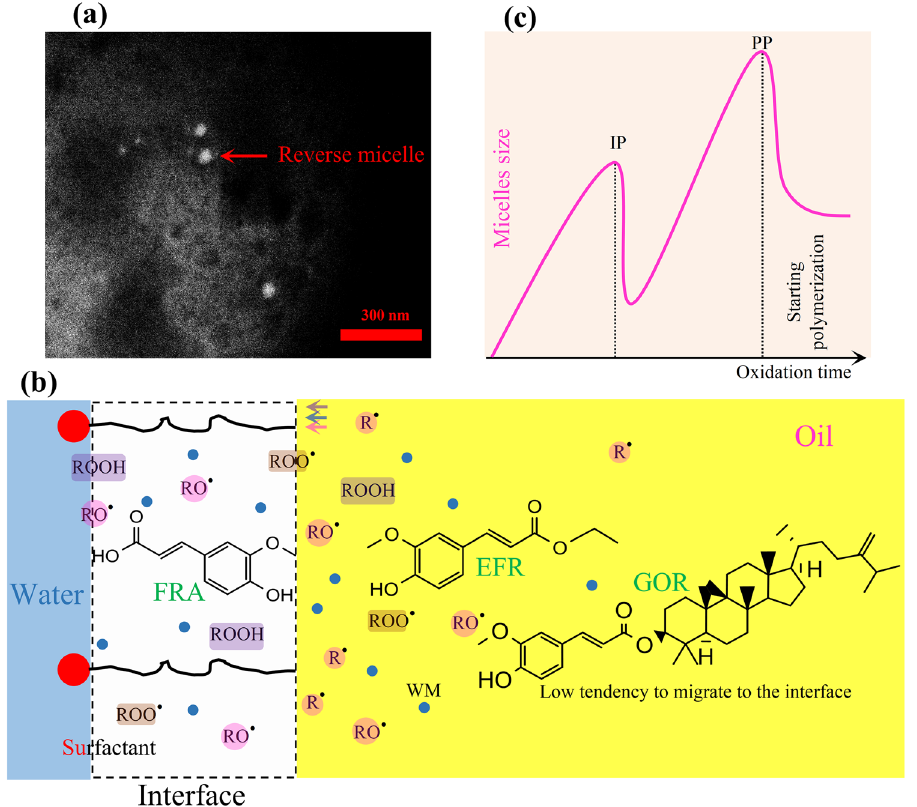
Figure 3. ( a ) TEM image of reverse micelles structures in the presence of γ-oryzanol during the induction period, ( b ) schematic figure of the cross-section of a reverse micelle produced during the oxidation process and a display of the dynamics of oxidation products as well as partitioning of the antioxidants under study in this structure ( EFR ethyl ferulate, FRA ferulic acid, GOR γ-oryzanol, R • alkyl radical, RO • alkoxyl radical, ROO • peroxyl radical, ROOH hydroperoxide, WM water molecule), ( c ) the changes in the trend of reverse micelles size during peroxidation of stripped sunflower oil at 60